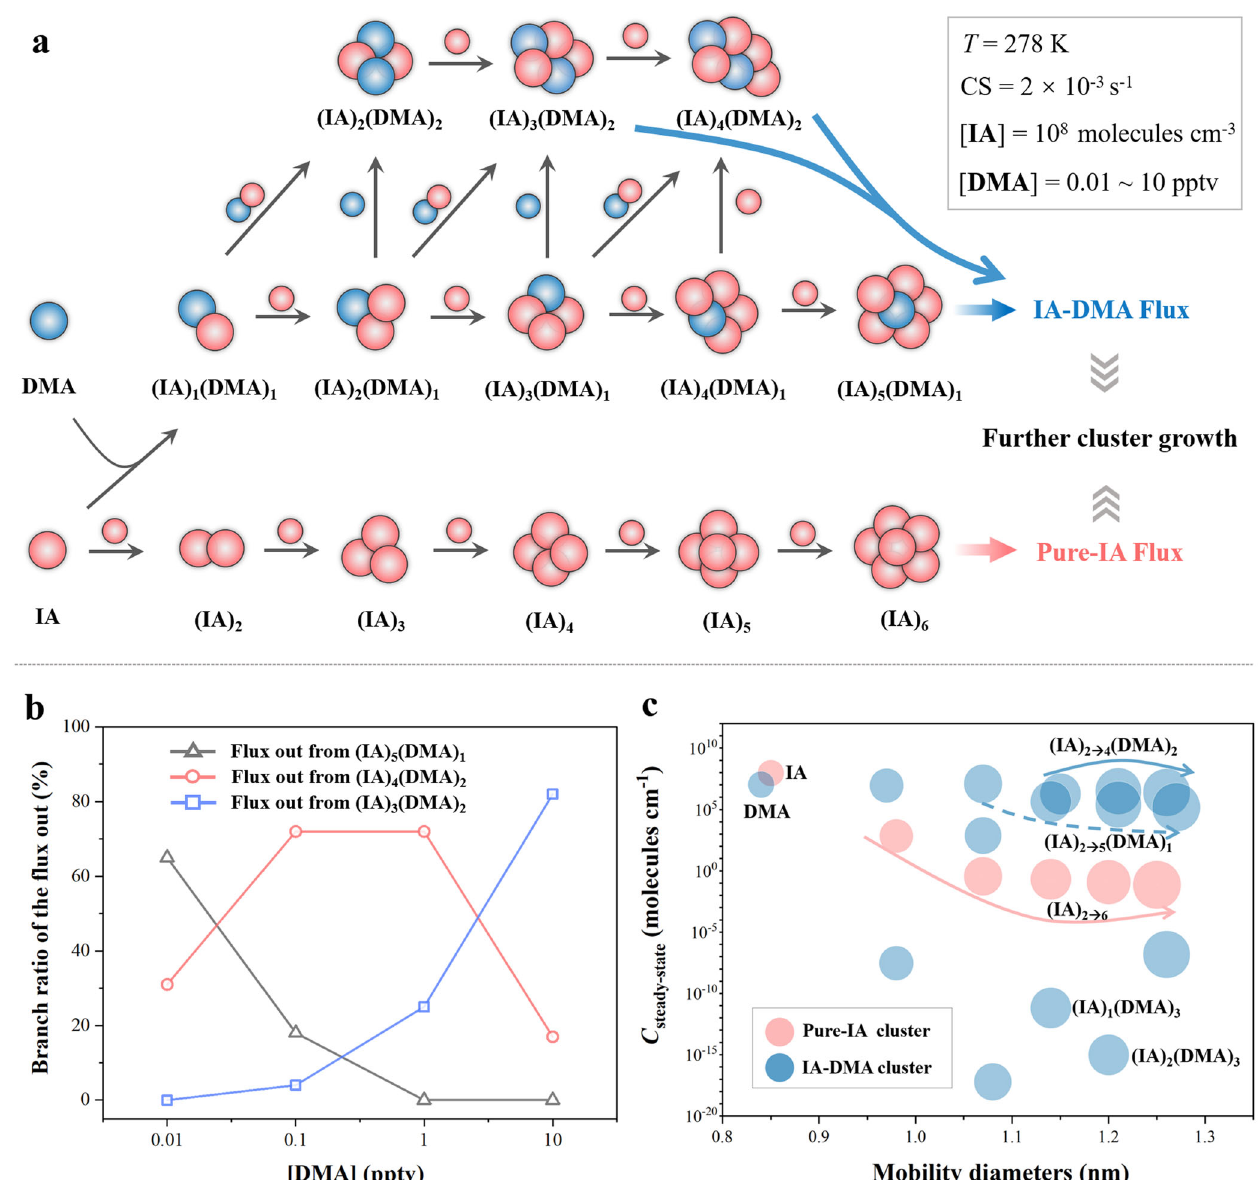
Fig. 5 Cluster formation pathways and the corresponding contributions. a Cluster formation pathway of IA-DMA system under the condition of T = 278 K, CS = 2 × 10 − 3 s − 1 , [IA] = 10 8 molecules cm − 3 , and [DMA] = 0.01~10 pptv. b Branch ratio of the fl ux out (%) against different [DMA]. c Steady-state cluster concentrations against cluster mobility diameters ( D M , nm), where the circle size is proportional to the D M . The red and blue arrows correspond to the pure-IA and IA-DMA clustering pathways in a ,